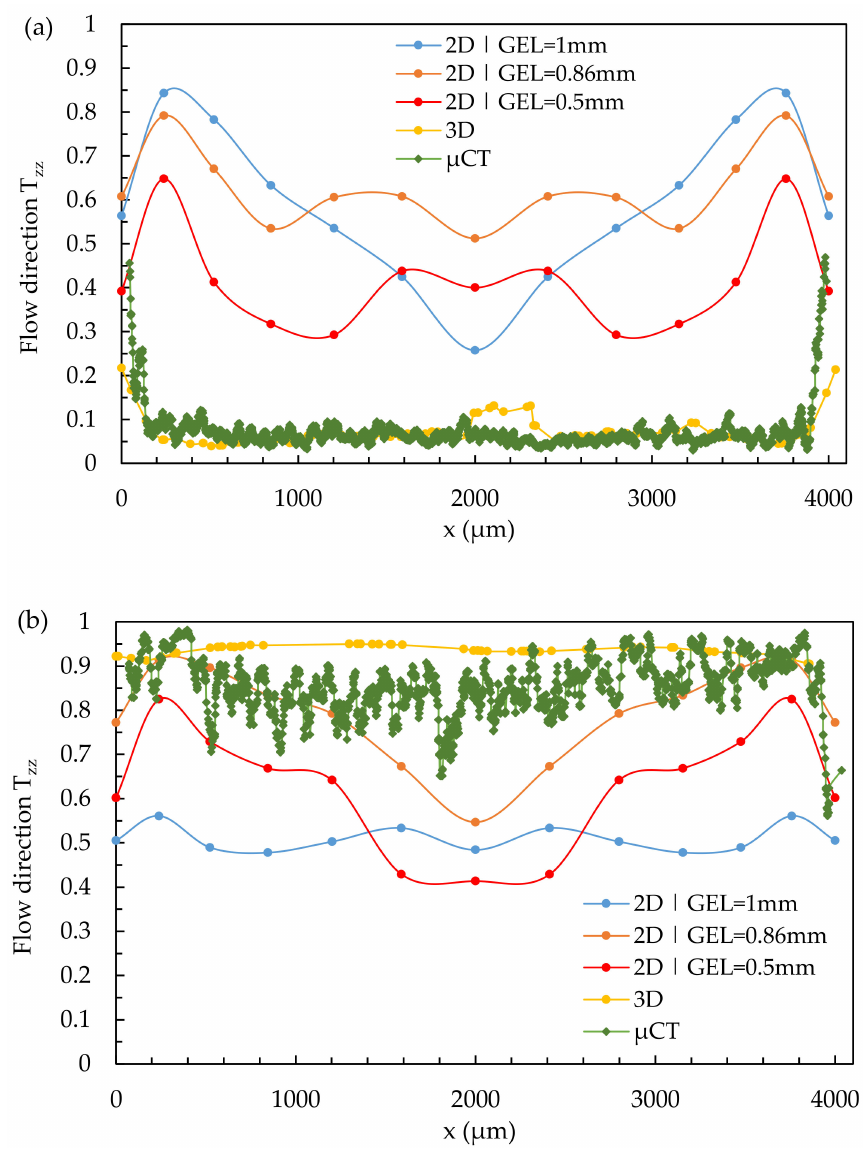
Figure 14. Quantitative results of fiber orientation in T zz -direction over the cross-section characterized by µ CT and predicted by the Dual Domain mesh under variation of the GEL at locations 2.2 ( a ) and 2.3 ( b